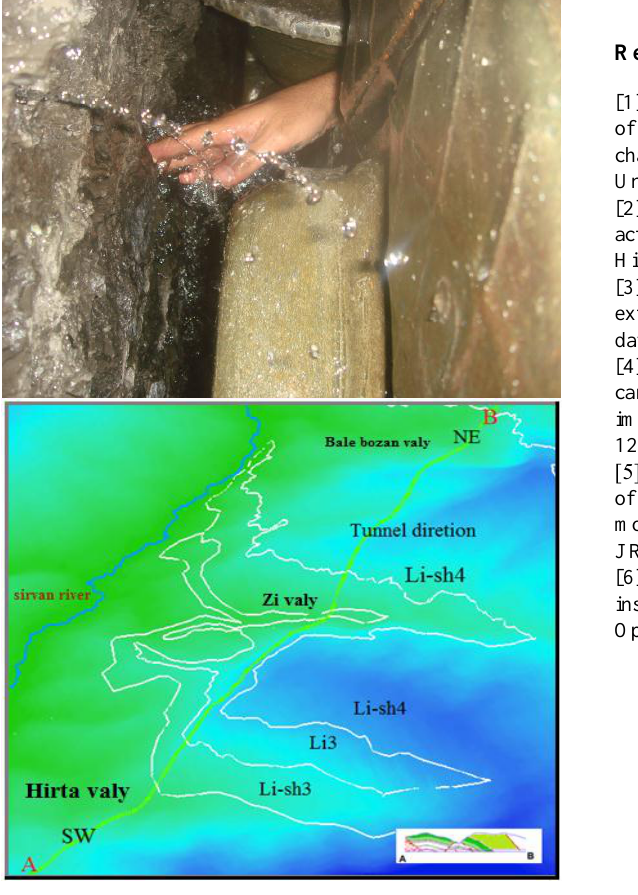
Fig 13. Top: a view of the tunnel face and entrance of water through cracks. Down: 3D view of engineering geology units Li3, Li-Sh3 and Li-sh4